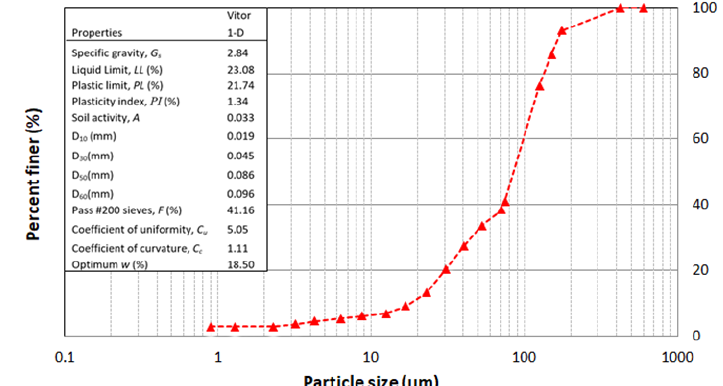
Figure 1. Particle size distribution of the raw MTs.